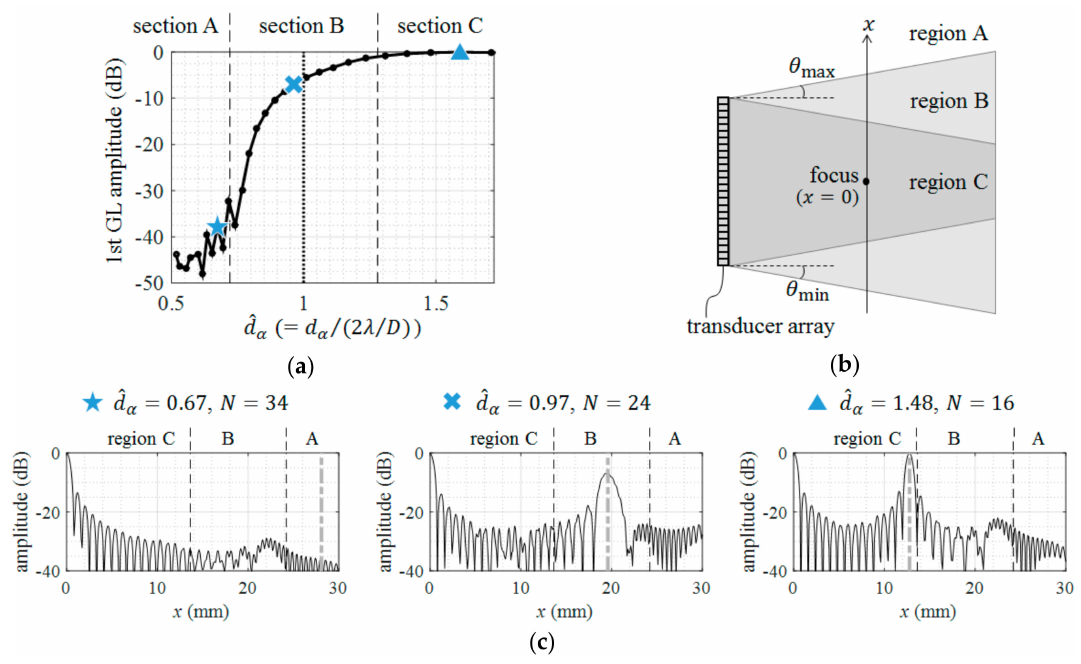
Figure 4. Magnitude of the first GL normalized by that of main lobe when the GL is located in regions A, B, and C. ( a ) Magnitude of the first GL in a simulated Tx beam pattern versus ˆ d α . ( b ) Region where none of (region A), more than one of (region B), and all of (region C) the collimated beam areas of PWs overlap. ( c ) Simulated beam patterns when using ˆ d α (marked with star, cross, and triangle in a (from left to right panels)). The gray dash-dot line indicates the theoretical first GL position, x GL,1 , of each beam